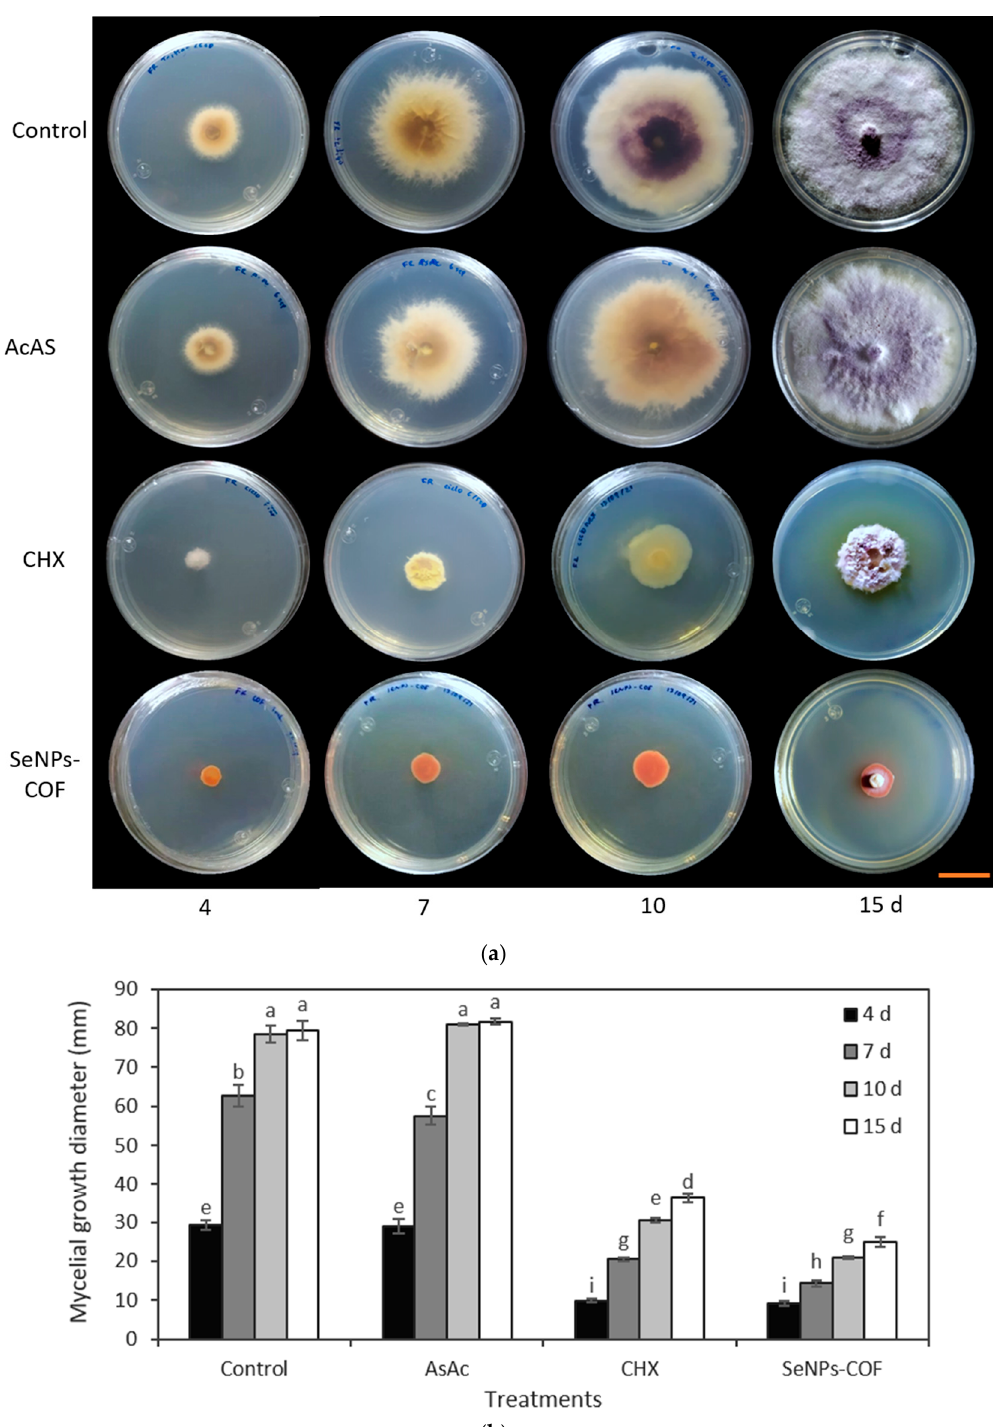
Figure 6. Antifungal activity of SeNPs synthesized with C. officinalis (COF) extracts against F. oxysporum . ( a ) Representative photograph of the antifungal activity test under different treatments over time. SeNPs and CHX were applied at 1.7 mg/mL and 2.5 mg/mL, respectively. The scale bar is 2.5 cm. ( b ) Mean comparison of the effect of the SeNPs synthesized with extracts of C. officinalis against F. oxysporum . Mean values ± ee. Different letters indicate statistically significant differences according to Duncan’s test ( α = 0.05), p < 0.0001.